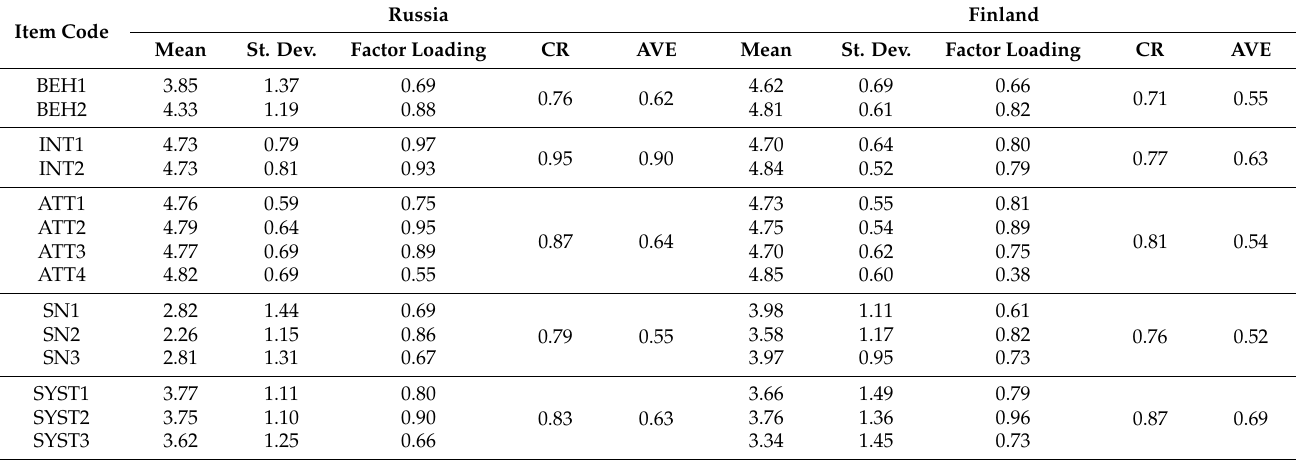
Table 3. Descriptive statistics and the results of the measurement model assessment (items corre- sponding to items’ codes are given in Supplementary